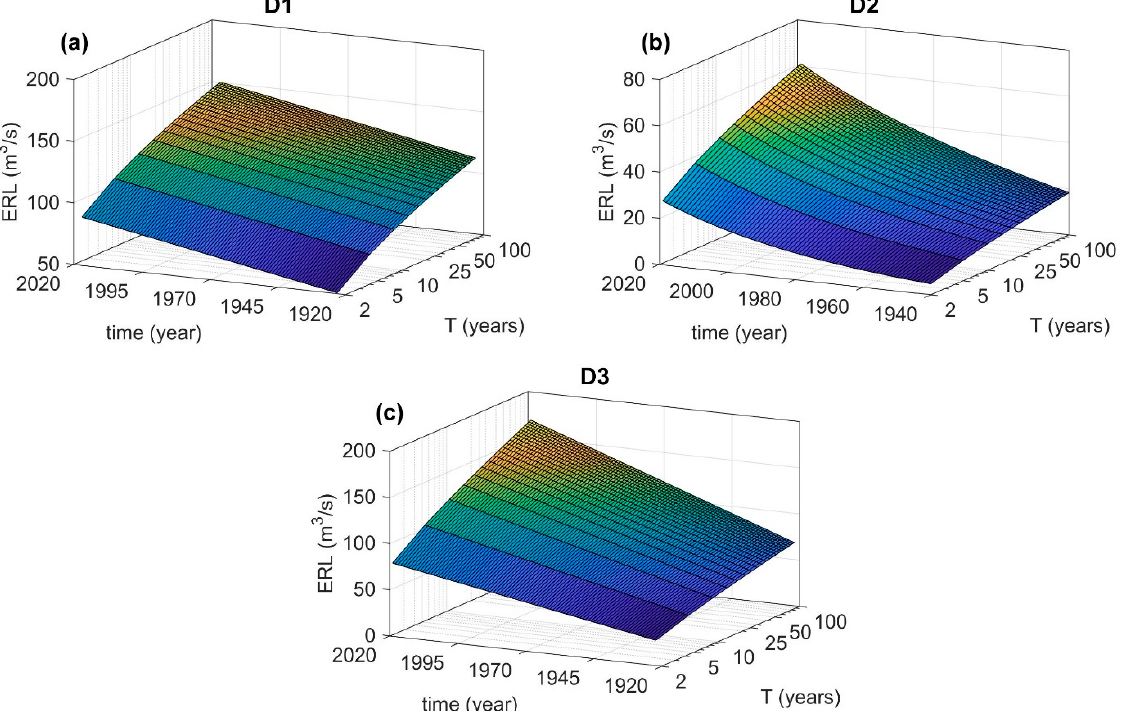
upward trends were detected in both the mean and standard deviation in the D2 and D3 (over the entire observation period).